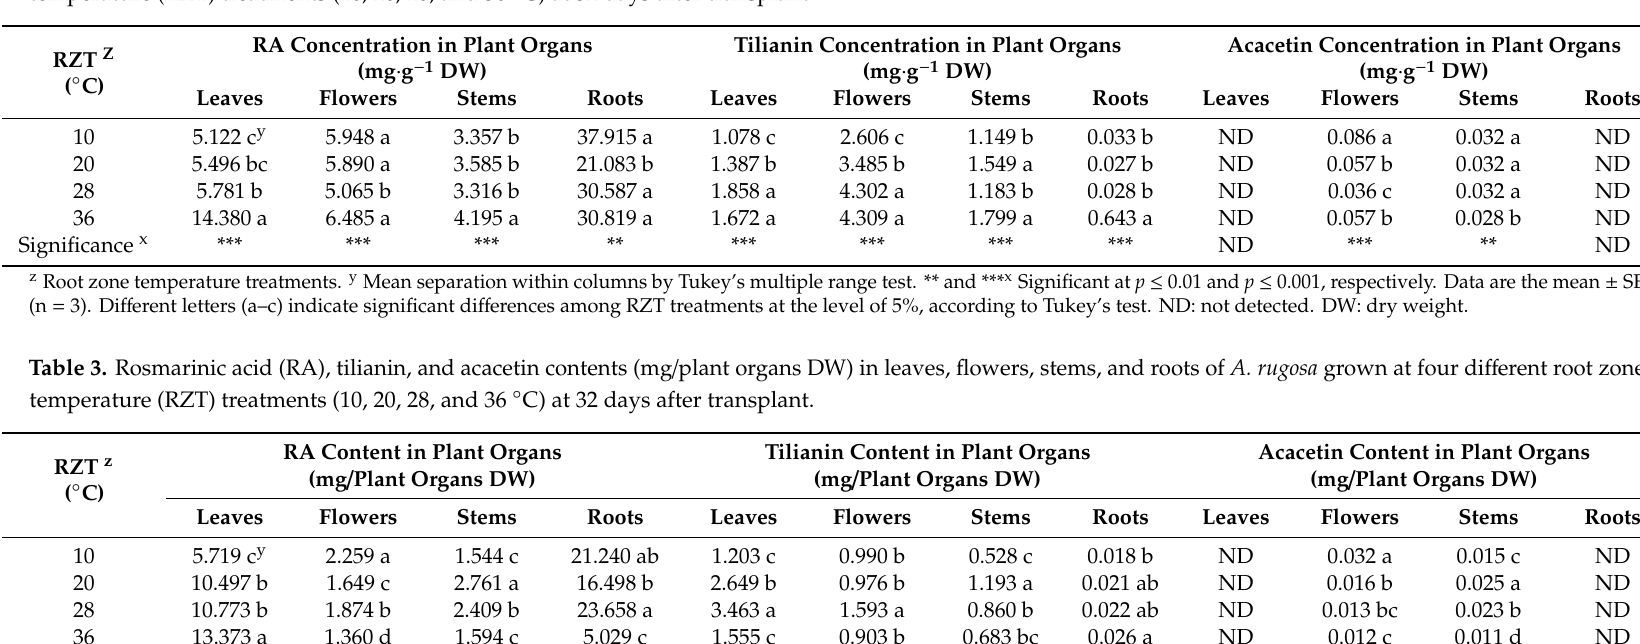
Table 2. Rosmarinic acid (RA), tilianin, and acacetin concentrations (mg · g − 1 DW) in leaves, flowers, stems, and roots of A. rugosa grown at four di ff erent root zone temperature (RZT) treatments (10, 20, 28, and 36 ◦ C) at 32 days after transplant. RZT Z ( ◦ C)